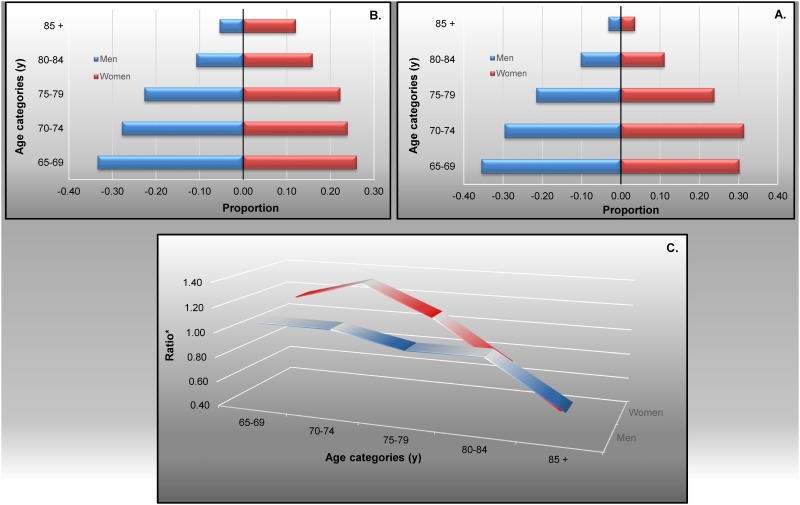
Population pyramid of the overall participants (A) and of seniors from Luxembourg (B): Comparison by gender and age (C).(A) Overall participants: per age group and gender, numbers compared to the total amount of subjects over 64 years old. (B) Luxembourgish seniors: per age group and gender, numbers compared to the total amount of subjects over 64 years old. (C) Representativeness depending on age groups and gender: the overall participants compared with the Luxembourgish seniors. Overall participants include full-participants and partial participants to the MemoVie study (n = 438). National statistics 2006, from: http://www.statistiques.public.lu/stat/TableViewer/tableView.aspx?ReportId=385&IF_Language=eng&MainTheme=2&FldrName=1 (n = 66,000)